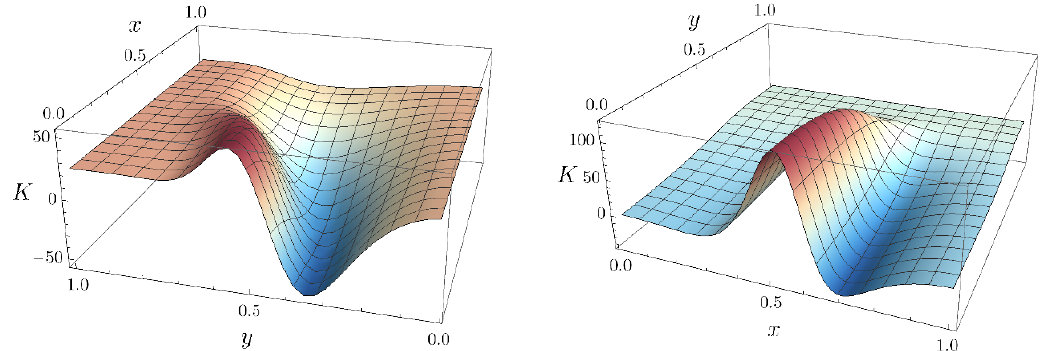
Figure 22 . Left : Kretschmann scalar K for the dominant soliton branch, " = 2 : 564. Right : K for a large black hole with " = 1 : 9.